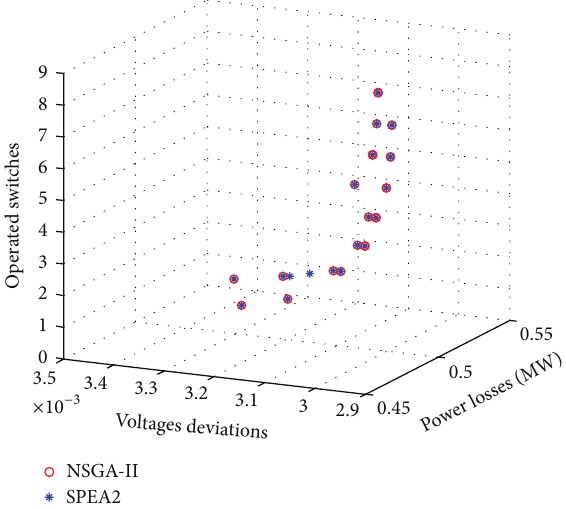
Figure 11: Approximate Pareto-optimal solutions to the problem of optimizing 𝑓 1 , 𝑓 2 , and 𝑓 3 .